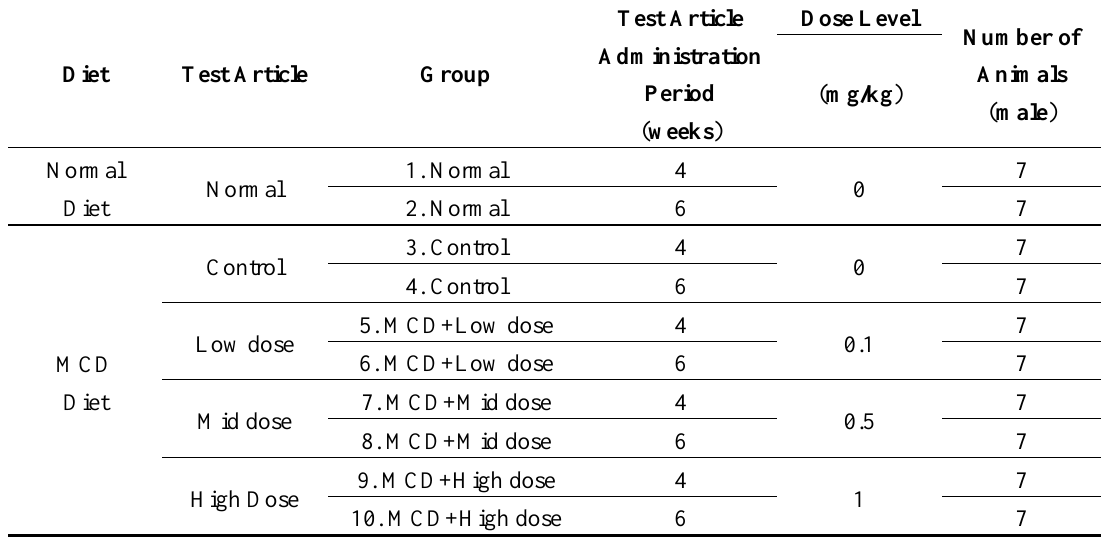
Table 2. Experimental Design: after supplying MCD diet for 8 weeks to induce NASH model, seventy animals were assigned to an each treatment